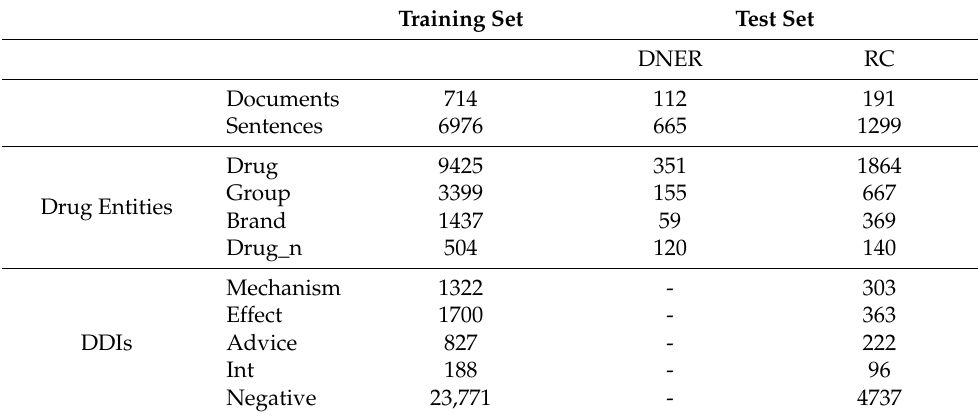
Table 1. The DDI-Extraction 2013 corpus